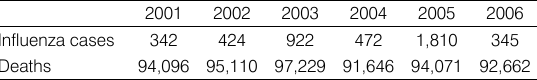
Table 1. Number of influenza cases and deaths in Baden- Wuerttemberg, Germany, 2001-2006.